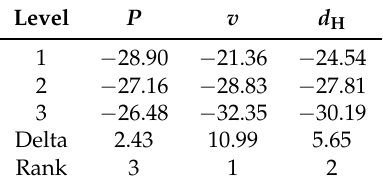
Table 9. Average S/N ratios for upskin